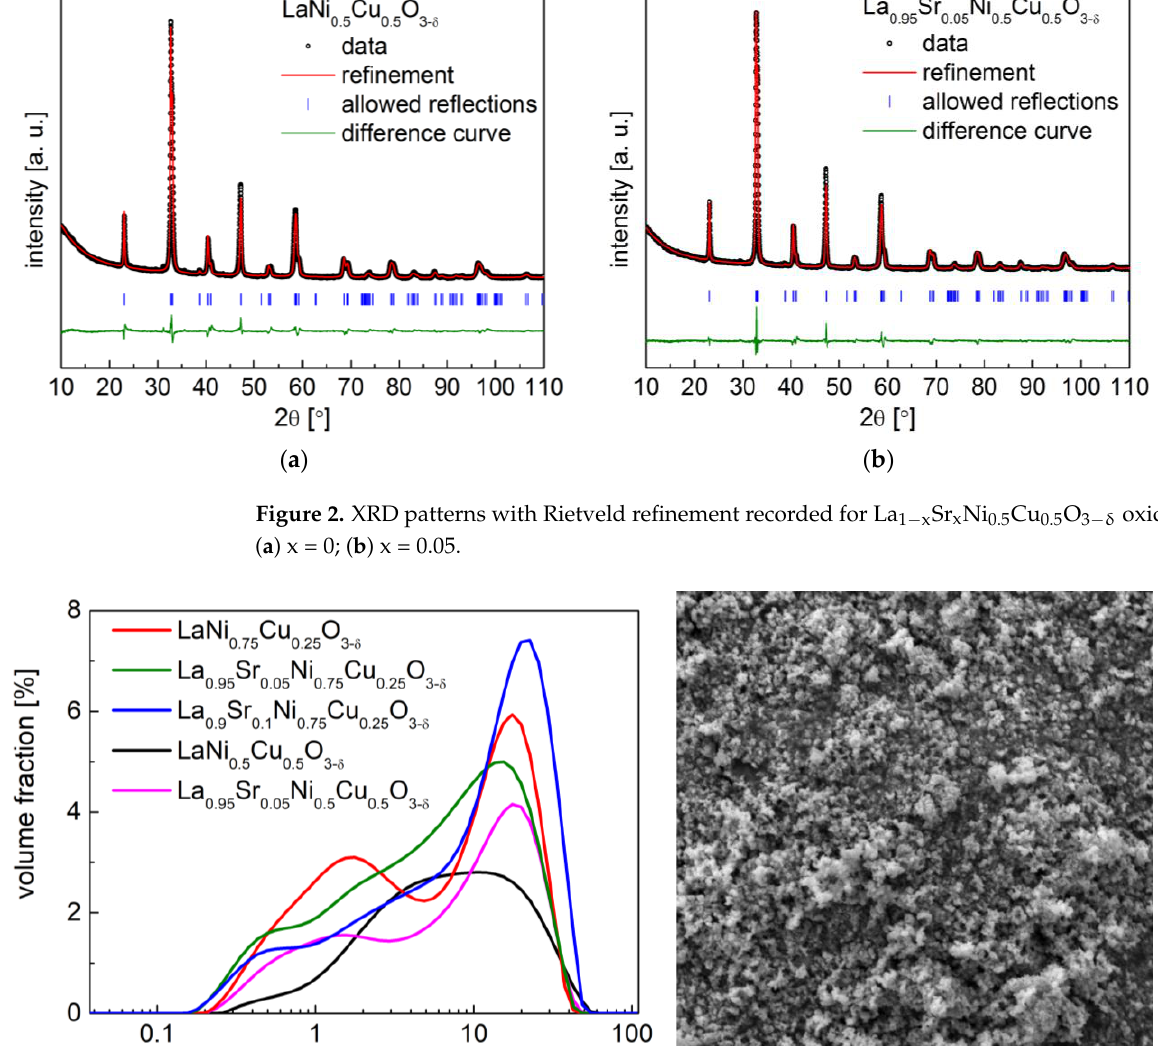
Figure 1. XRD patterns with Rietveld refinement recorded for La 1−x Sr x Ni 0.75 Cu 0.25 O 3−δ oxides with ( a ) x = 0; ( b ) x = 0.05; ( c ) x = 0.1; ( d ) XRD patterns of La 0.85 Sr 0.15 Ni 0.75 Cu 0.25 O 3−δ oxides. Figure 2. XRD patterns with Rietveld refinement recorded for La 1−x Sr x Ni 0.5 Cu 0.5 O 3−δ oxides with ( a ) x = 0; ( b ) x = 0.05. Table 1. Rietveld refinement results for as-synthesized La 1−x Sr x Ni 1−y Cu y O 3−δ oxides. Composition